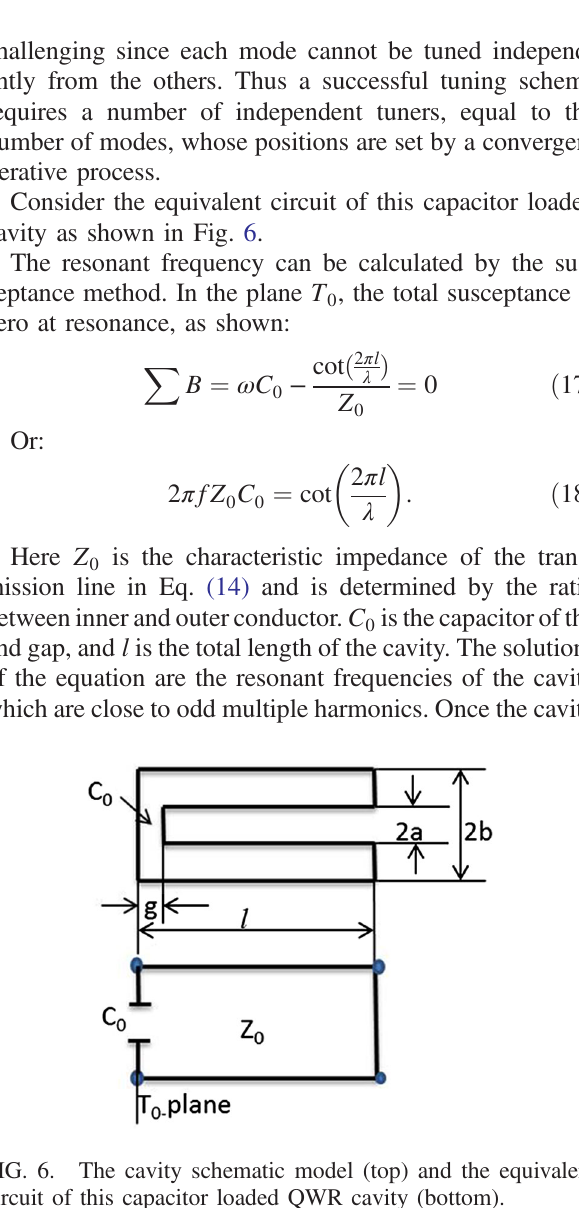
FIG. 5. Transit time factor (left) and the required compensated power (right) change with the particle velocity.